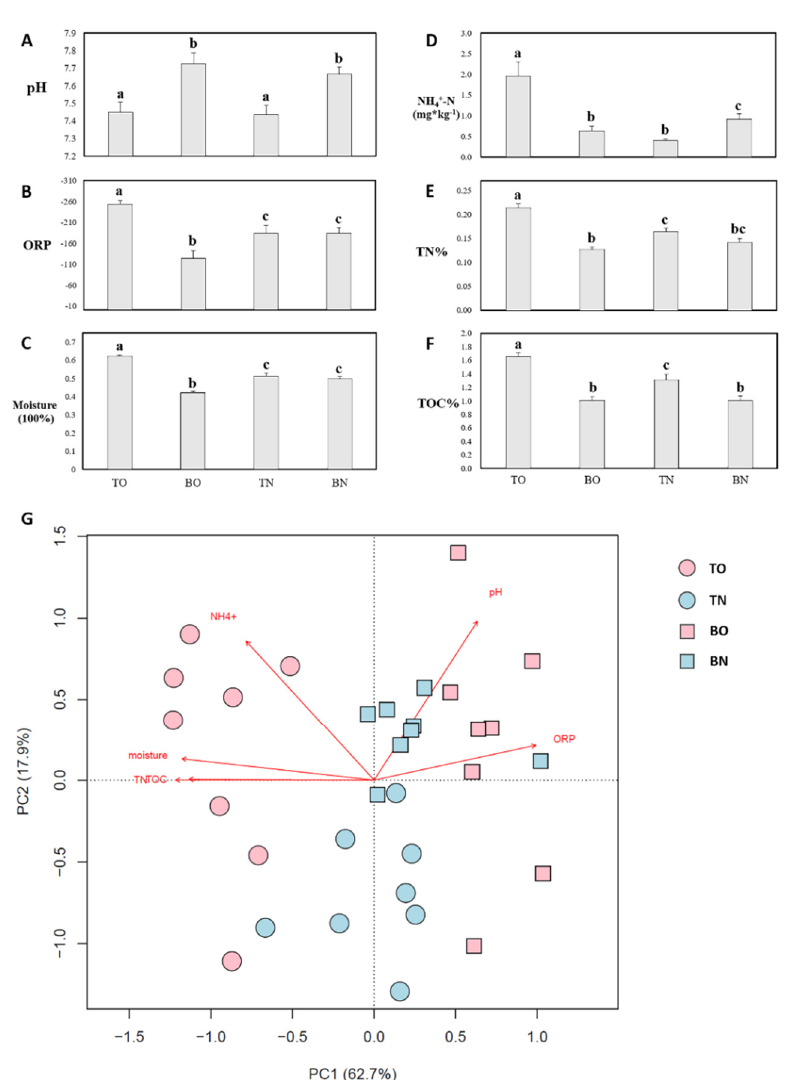
Figure 2. Environmental parameters. ( A – F ) Environmental parameters of the four groups. Groups sharing the same letter were not significantly different according to that parameter ( n = 8, p < 0.05. Error bars, mean ± standard deviation); ( G ) PCA. Each point is one sample. Environmental param- eters are shown as red arrows. Percentages in parentheses are proportional differences between parameters represented by the PC